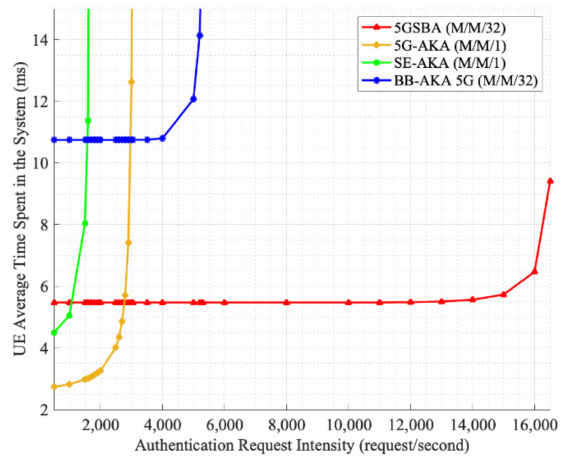
Figure 10. Average delay under many